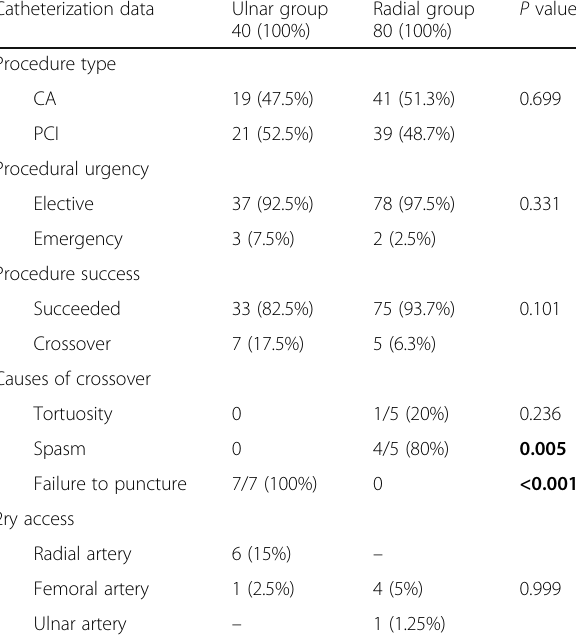
Table 2 Catheterization data of the whole study